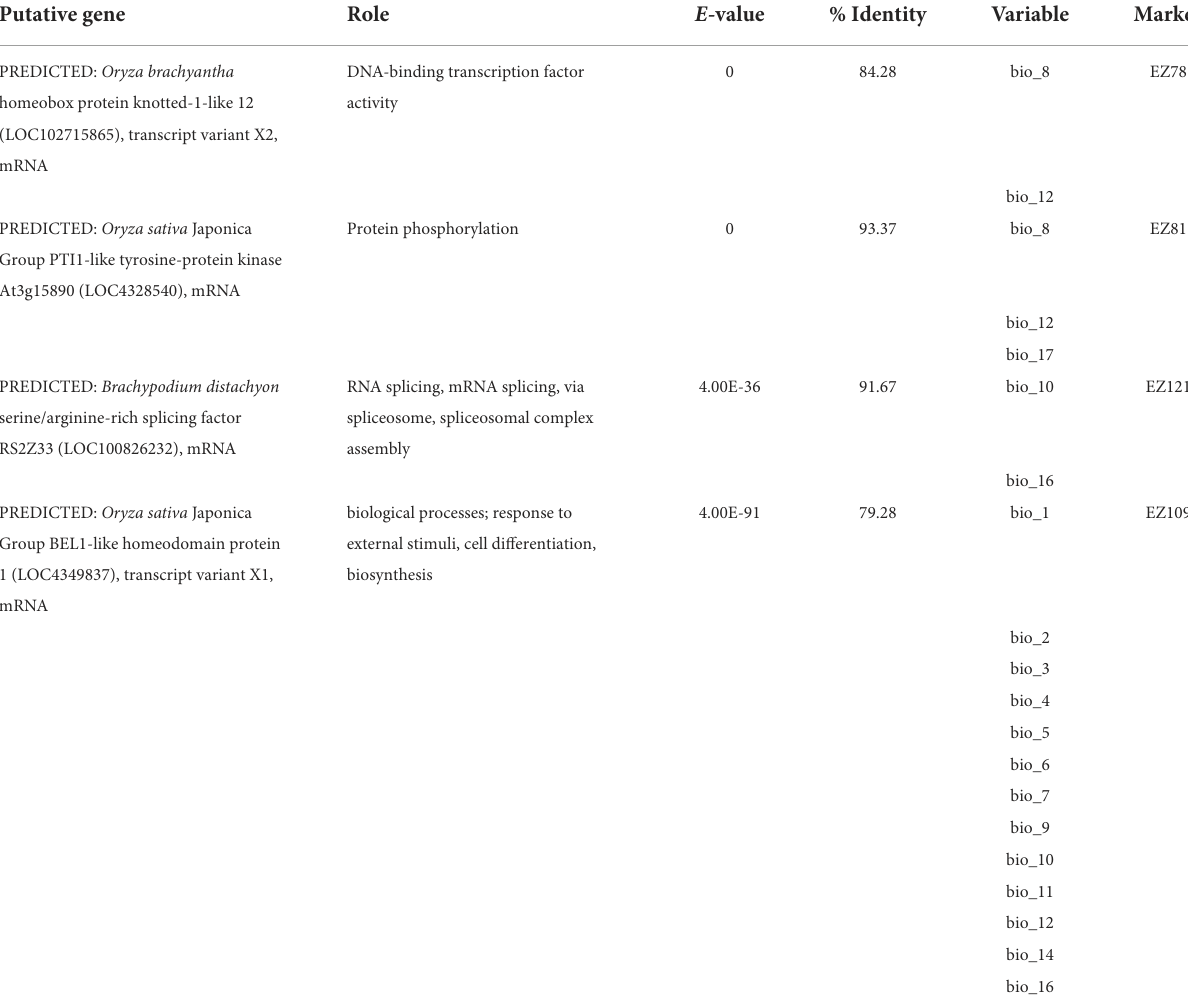
TABLE 2 Putative function of adaptive loci that were outliers and associated with climatic variables. Putative gene Role E -value % Identity Variable